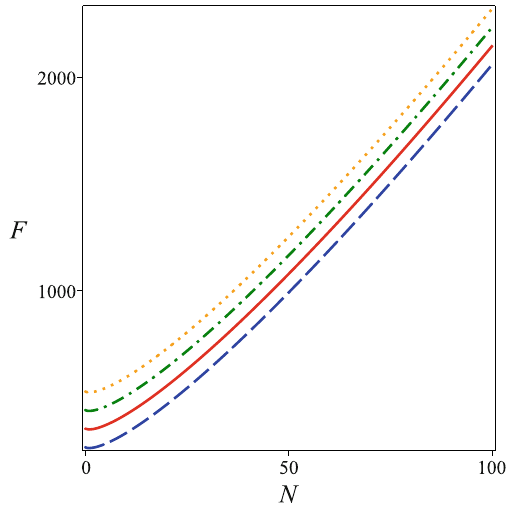
Fig. 2 Typical behavior of the Helmholtz free energy in terms of N . N l = 5; l = 1 , 2 , 3 (blue dash), l = 1 , 2 , 3 , 4 (red solid), l = 1 , 2 , 3 , 4 , 5 (green dash dot); l = 1 , 2 , 3 , 4 , 5 , 6 (orange